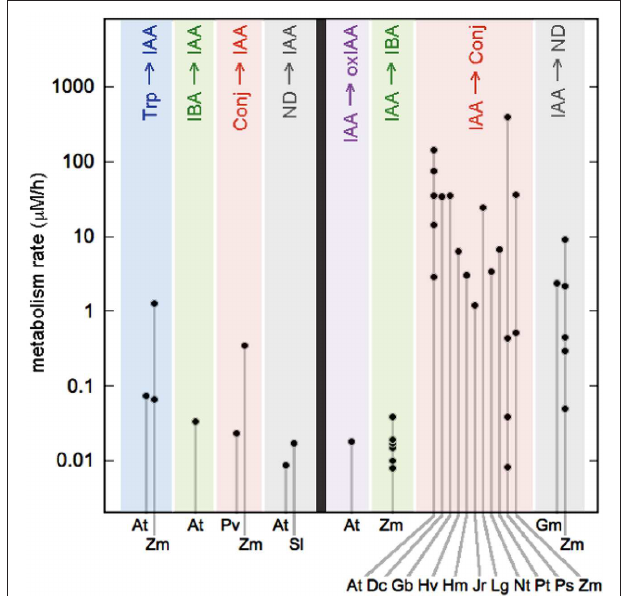
FIGURE 2 | Metabolic rates in seed plants. Metabolic pathways are distinguished by color and labeled at top with abbreviations introduced in Figure 1 (Conj, conjugates; ND, not determined). The left half of the figure shows metabolic pathways that add auxin to the tissue. The right half shows pathways that remove auxin. Abbreviations along the bottom indicate the various species for which data is available: At, Arabidopsis thaliana ; Dc, Daucus carota ; Gb, Gingko biloba ; Gm, Glycine max ; Hv, Hippuris vulgaris ; Hm, Hyoscyamus muticus ; Jr, Juglans regia ; Lg, Lemna gibba ; Nt, Nicotiana tabacum ; Pt, Pinus thunbergiana ; Ps, Pisum sativum; Pv, Phaseolus vulgaris ; Sl, Solanum lycopersicum ; and Zm, Zea mays . Rates are derived from published papers, as summarized in the main text and described fully in the Supplemental Information. Error bars (not shown) are ± 30%.